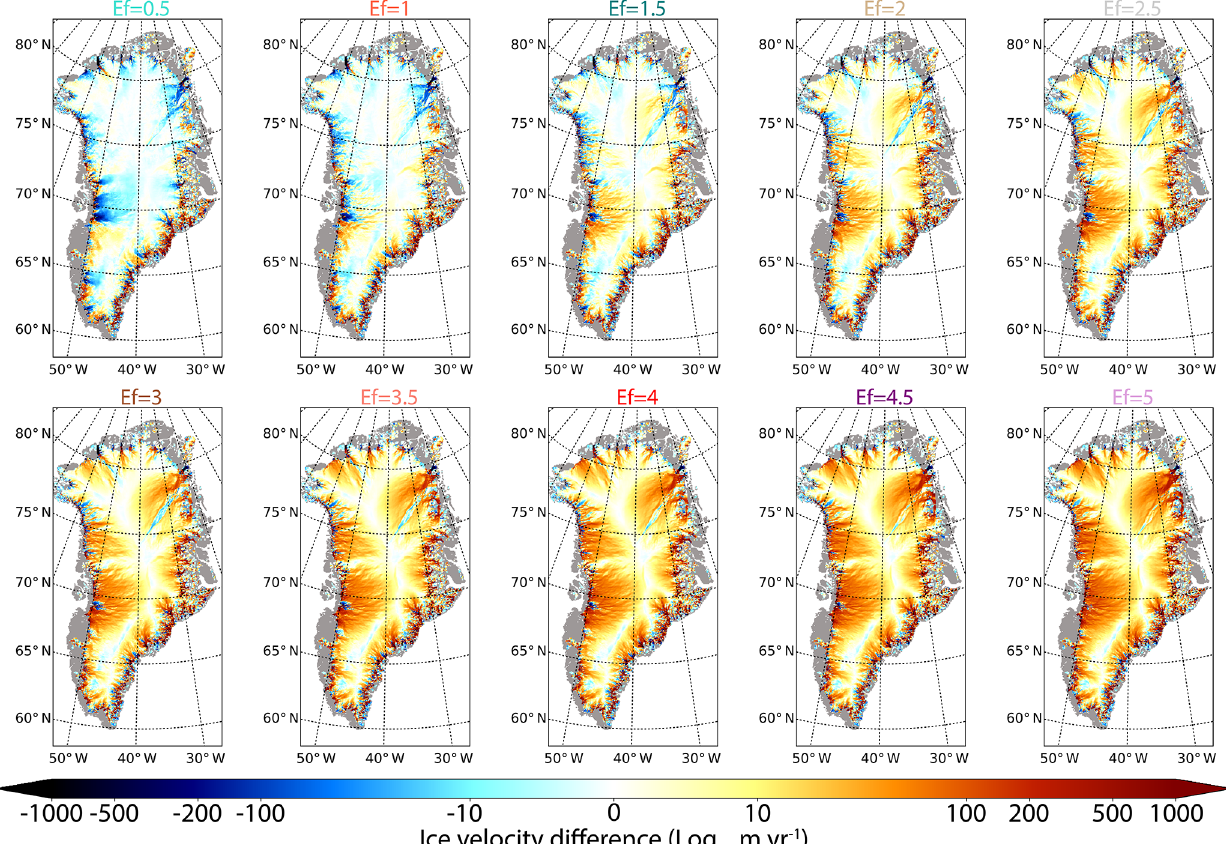
Figure 11. Simulated ice surface velocity difference (myr − 1 ) with respect to observations (Joughin et al., 2018) using Ef ranging from 0.5 to 5 for Nb inv = 20 years, Nb free = 200 years and Nb cycle that corresponds to the one producing the lowest ice thickness RMSE (see Table